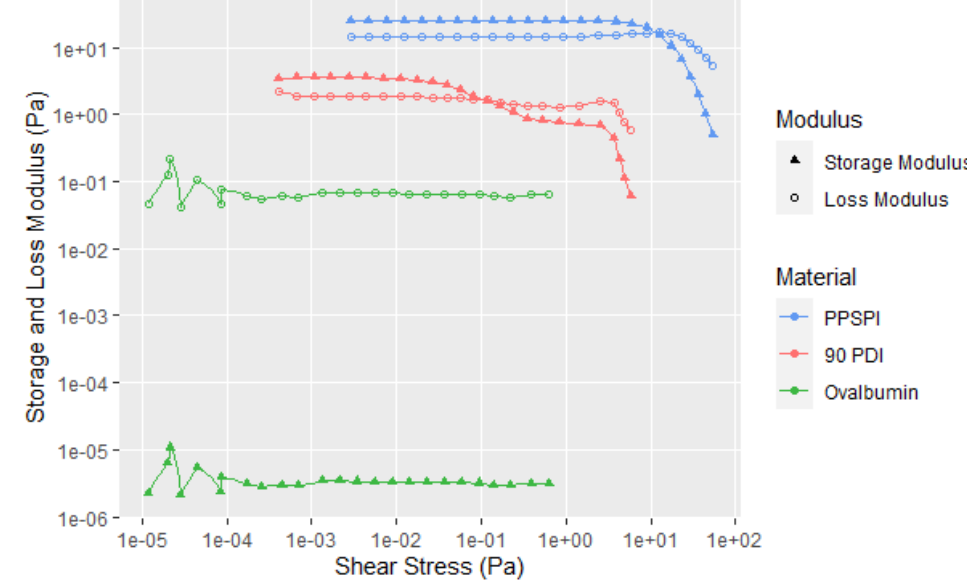
Figure 15. Shear rheology with increasing amplitude of PPSPI, 90 PDI flour, and ovalbumin, all with 15% protein content.